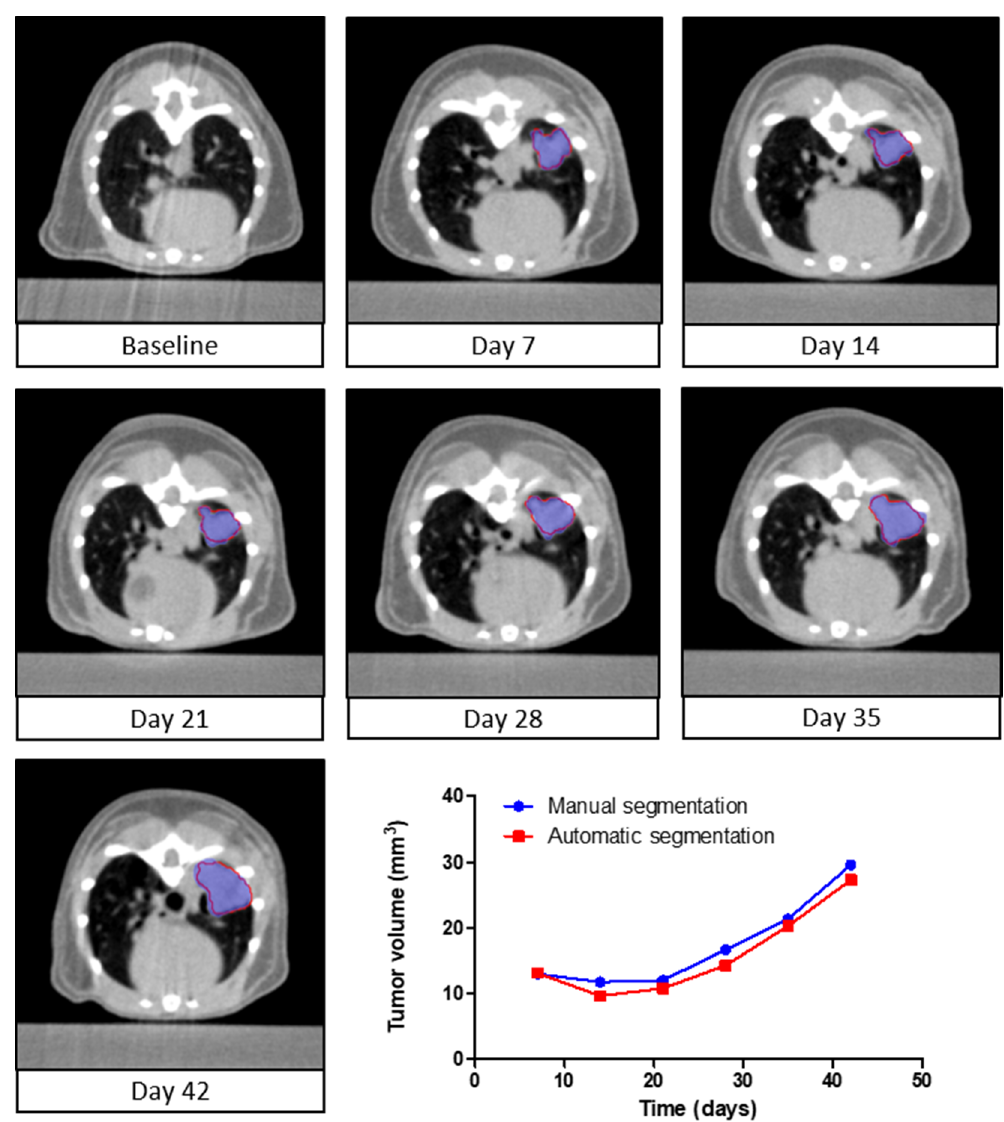
Figure 3. Longitudinal follow-up of tumor volume. A series of axial slices of µ CBCT images showing the manual segmentation (blue) and automatic segmentation (red) of the lung tumor in a single animal versus time. The µ CBCT images represent one mouse at seven different time points. The quantified manual (blue) and automatically (red) segmented volumes are presented over time in the line graph.